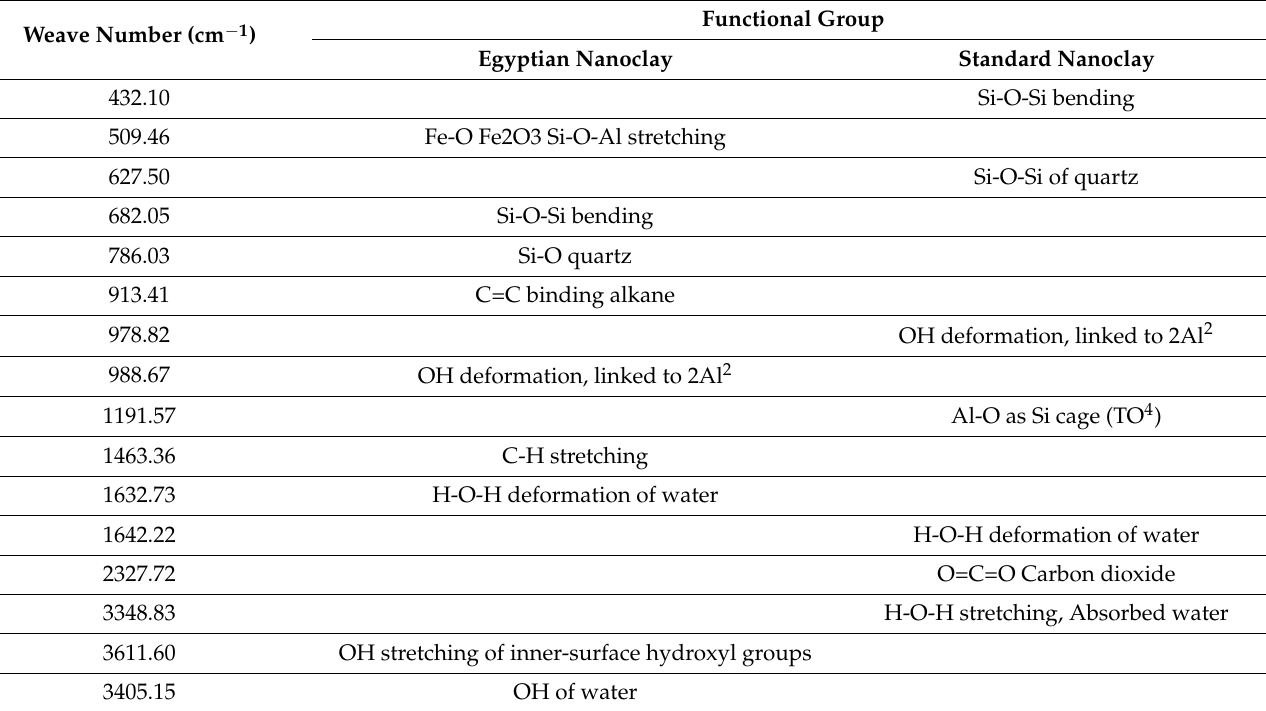
Figure 3. FTIR spectra of Egyptian nanoclay ( A ) and standard nanoclay ( B ). Table 2. FTIR spectra list of band positions for Egyptian and standard nanoclay in this study.